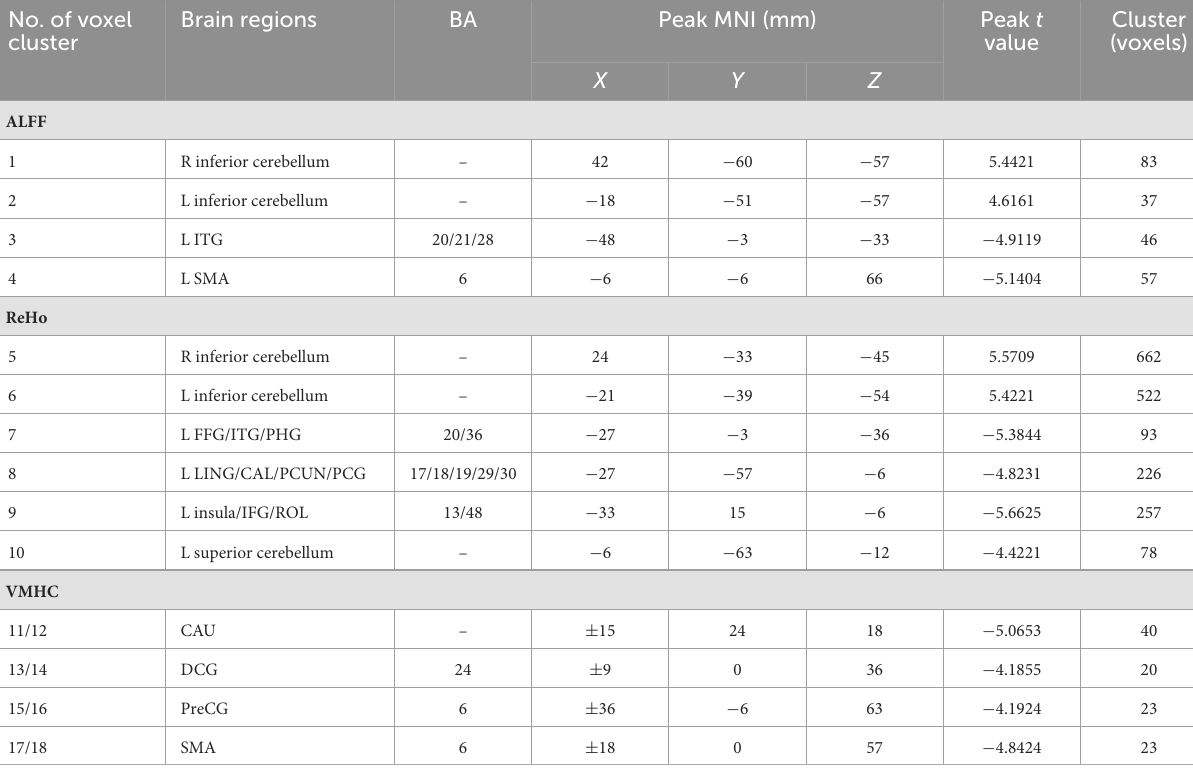
TABLE 2 Differences in amplitude of low-frequency fluctuation (ALFF), regional homogeneity (ReHo), and voxel-mirrored homotopic connectivity (VMHC) values between the patient and control groups [ p < 0.05, Gaussian Random Field (GRF) corrected]. No. of voxel cluster